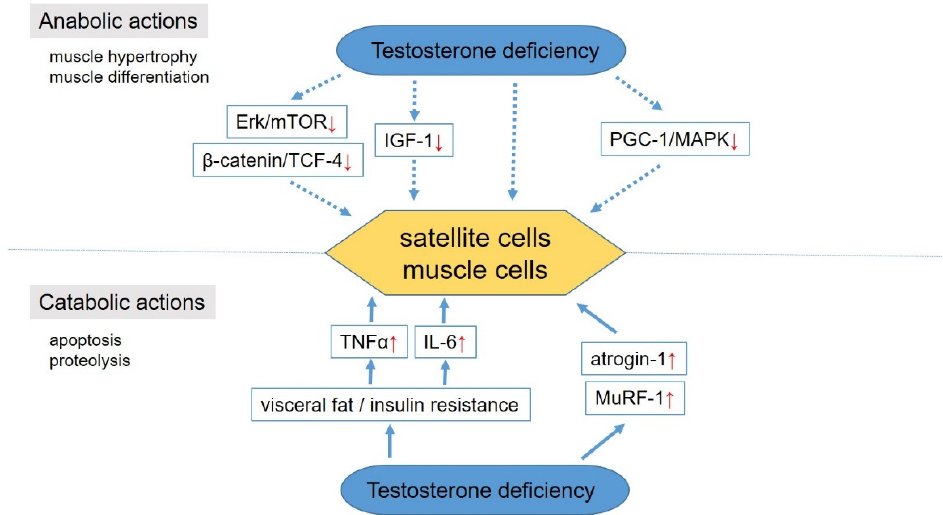
Figure 2. Molecular mechanisms in the development of sarcopenia. IGF-1, insulin-like growth factor–1; mTOR, mammalian target of rapamycin; TCF-4, T-cell factor-4; PGC-1α, peroxisome proliferator-activated receptor-gamma coactive tor 1 alpha; MAPK, p38 mitogen-activated protein kinases; TNF-α, tumor necrosis factor; IL-6, interleukin-6; MuRF-1, muscle atrophy-F-box (atrogin-1) and muscle RING-finger protein-1. An upward red arrow indicates “increase”, whereas a downward one indicates "decrease".